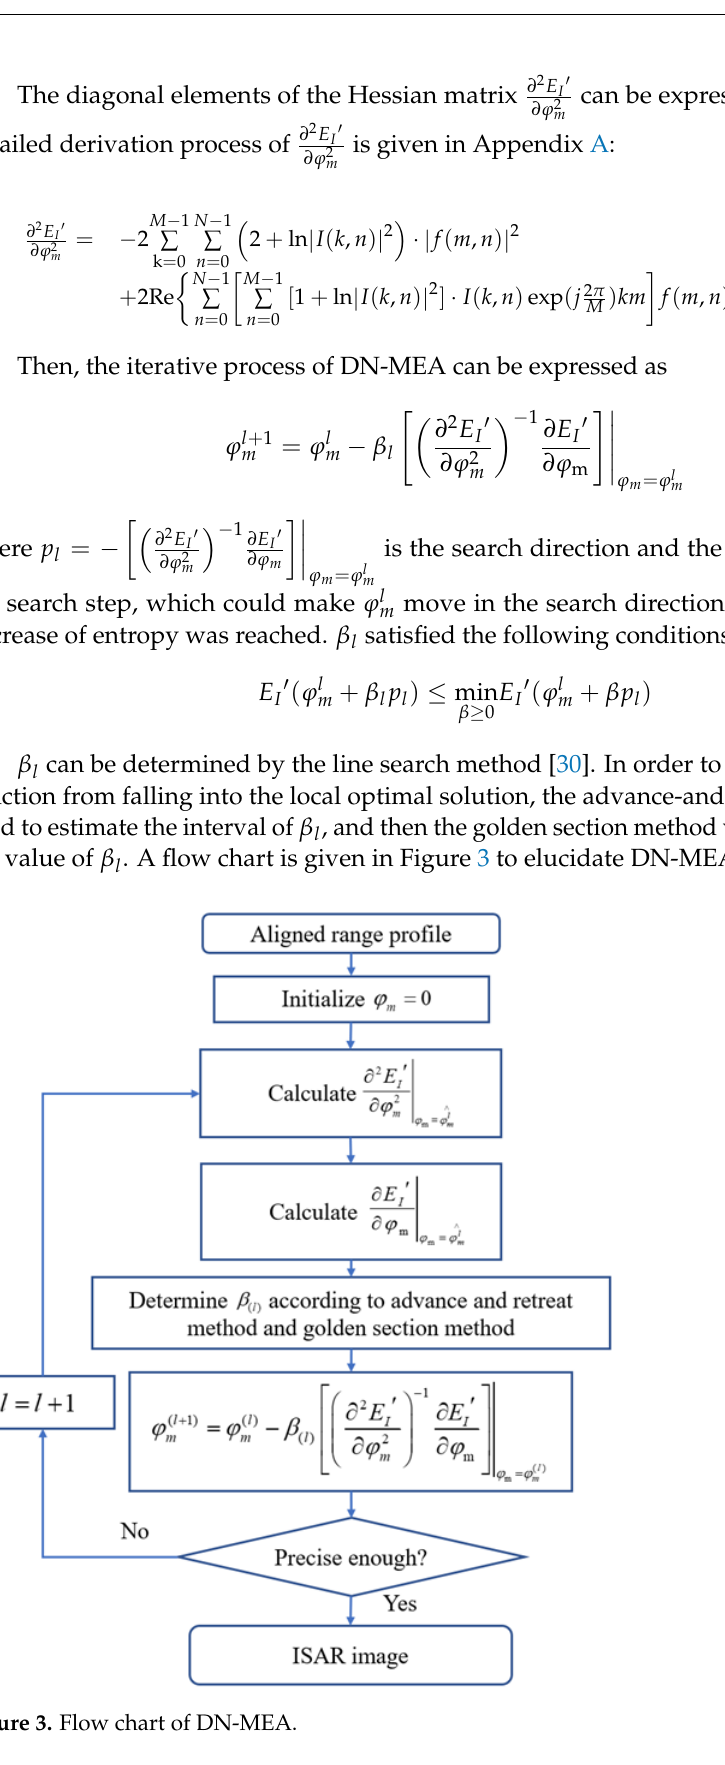
Figure 3. Flow chart of DN-MEA.